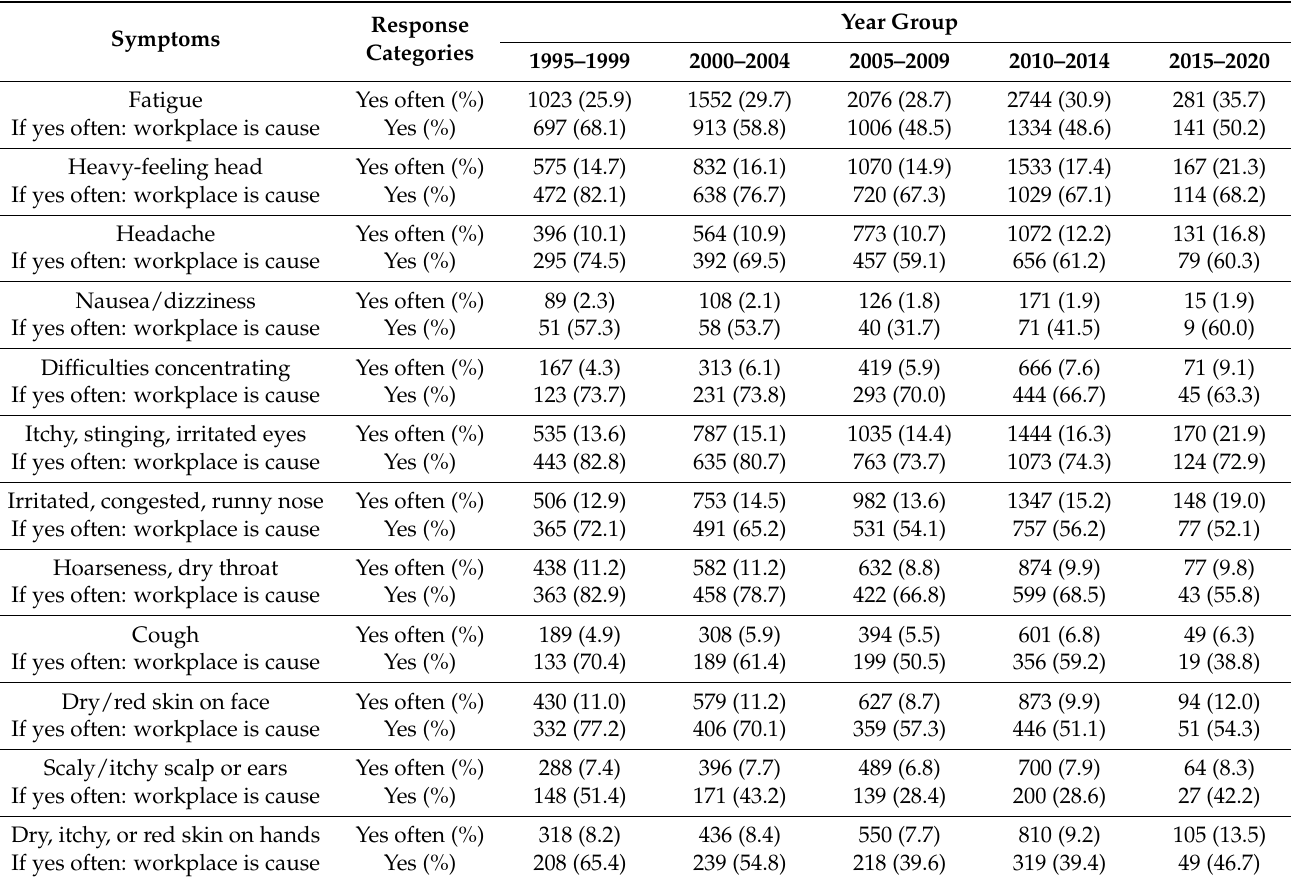
Table 2. Year group frequencies and percentages of 12 symptoms and the perceived causality to the workplace for each